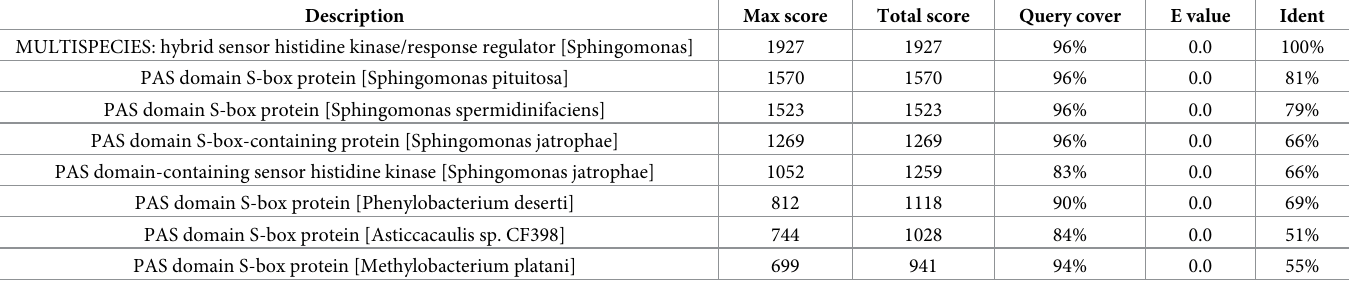
Table 2. The first 8 detailed alignment results of the suspected gene fragment 21-21000-24250 and different sequences in the database. Five metrics are used to evalu- ate the match results of the query sequence: Max score, Total score, Query coverage, E value, and